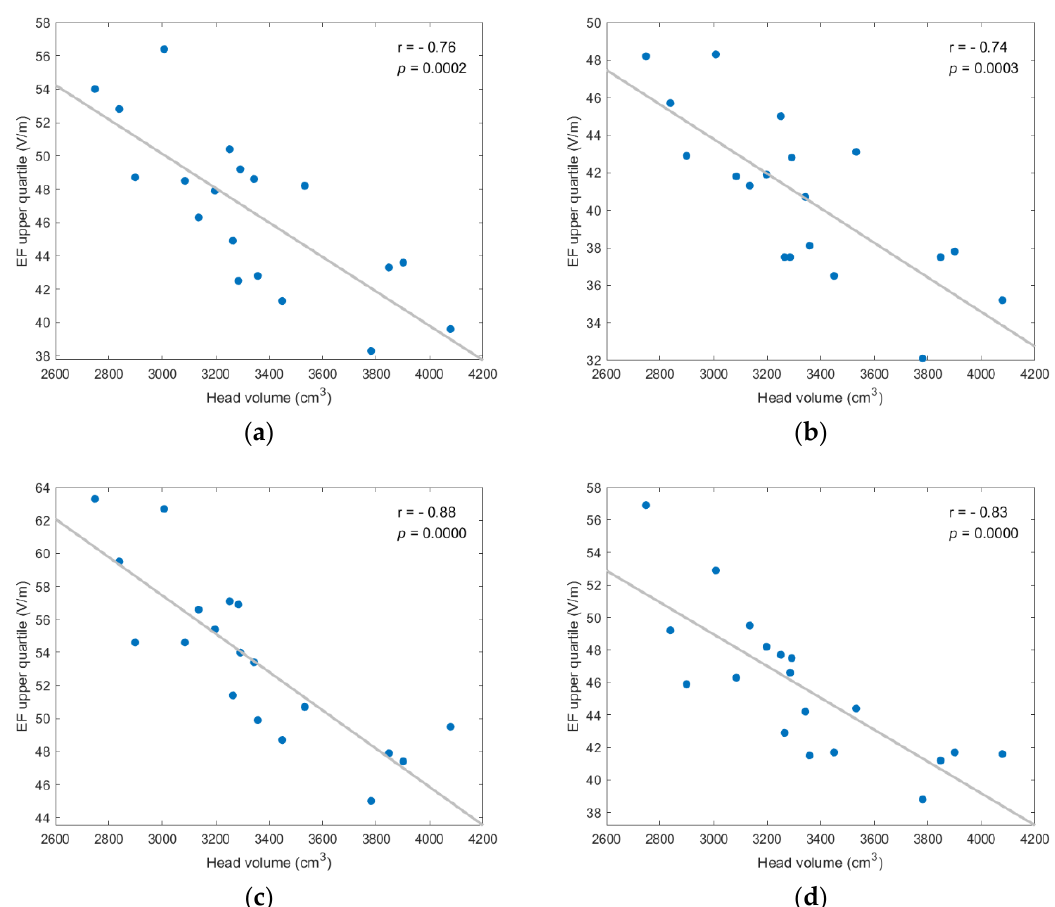
Figure A7. EF upper quartile showed strong, and statistically significant negative, correlation to head volume for every coil position/model version scenario; ( a ) frontal coil position on anatomical models; ( b ) frontal coil position on homogeneous models; ( c ) central coil position on anatomical models; ( d ) central coil position on homogeneous models.